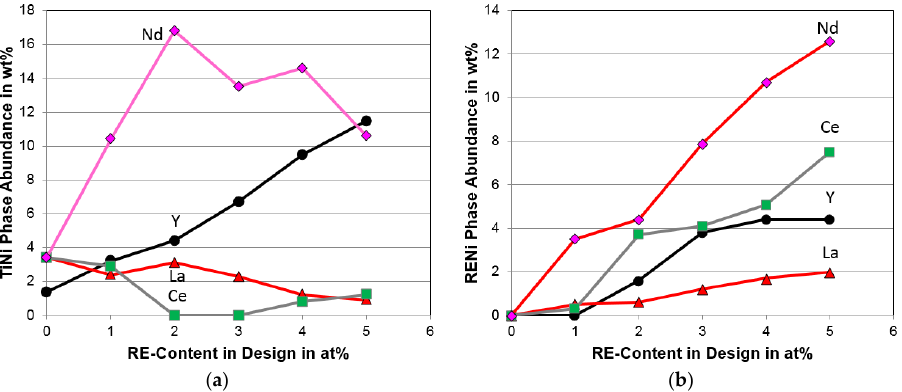
Figure 4. Evolutions of ( a ) TiNi and ( b ) RENi phase abundances with increasing RE-content in the design.